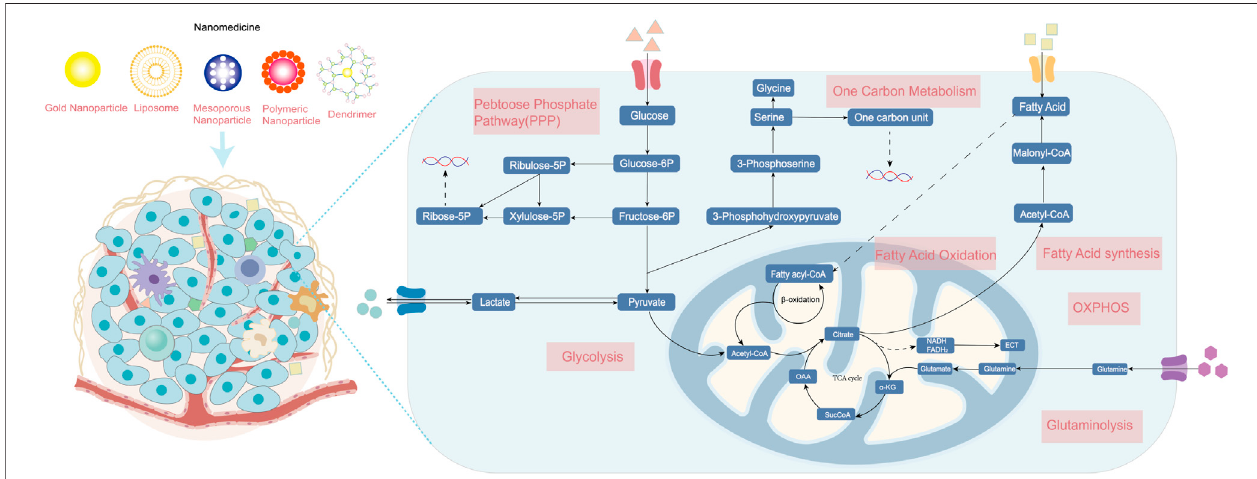
FIGURE 1 | The metabolism of cancer cells. Enhanced aerobic glycolysis, also known as the Warburg effect, enables cancer cells to generate large amounts of biomolecules for biomass production. Glutamine is converted into glutamate and ammonia in the process of glutaminolysis. The upregulation of de novo lipid synthesis and fatty acid oxidation is related to bioenergy synthesis and signaling molecules needed for proliferation. Various nanomedicines can target these metabolic vulnerabilities in cancer cells and improve therapeutic effects, including photothermal, gene, chemo-, and immunotherapy. ETC, electron transport chain; OXPHOS, oxidative phosphorylation; and TCA, tricarboxylic acid cycle.